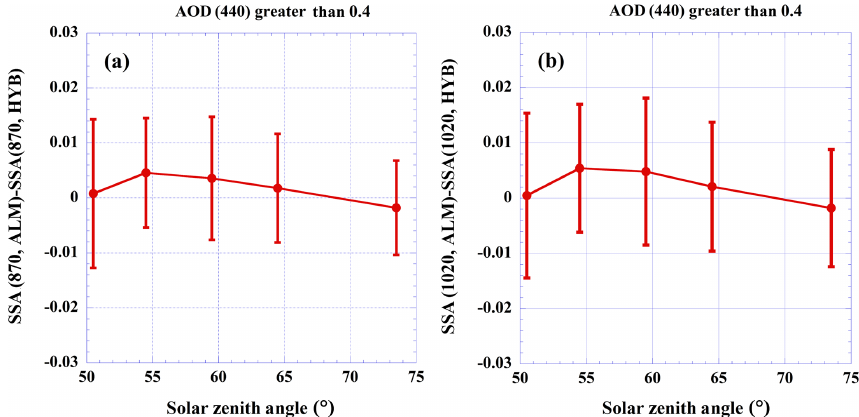
Figure 18. Difference in SSA retrieved from HYB and ALM scans. (a) 870; (b)